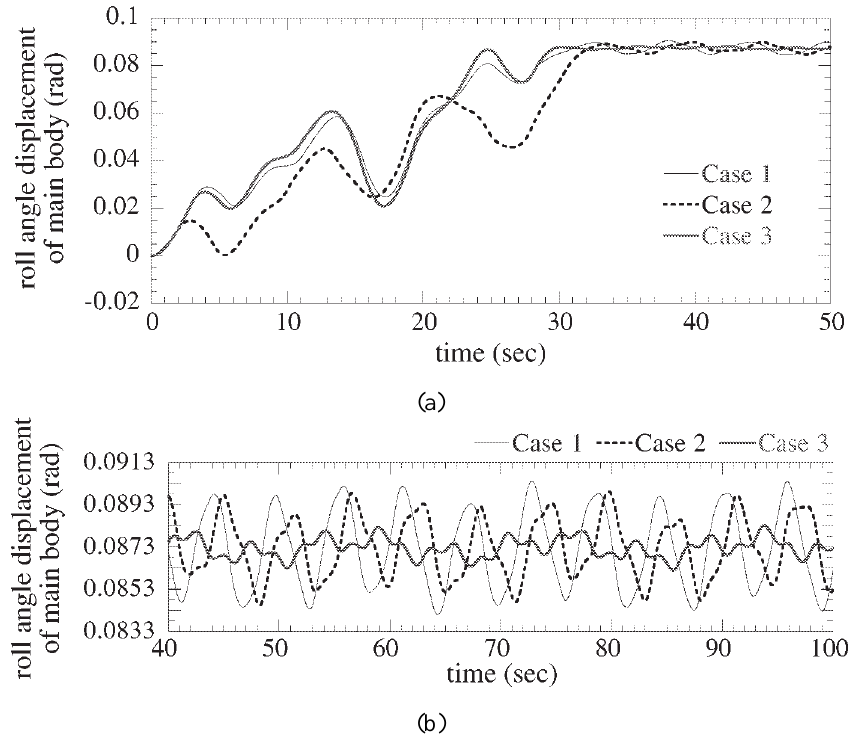
Fig. 9. Time responses of roll angle displacement of the main body: (a) during maneuver, (b) residual oscillation.